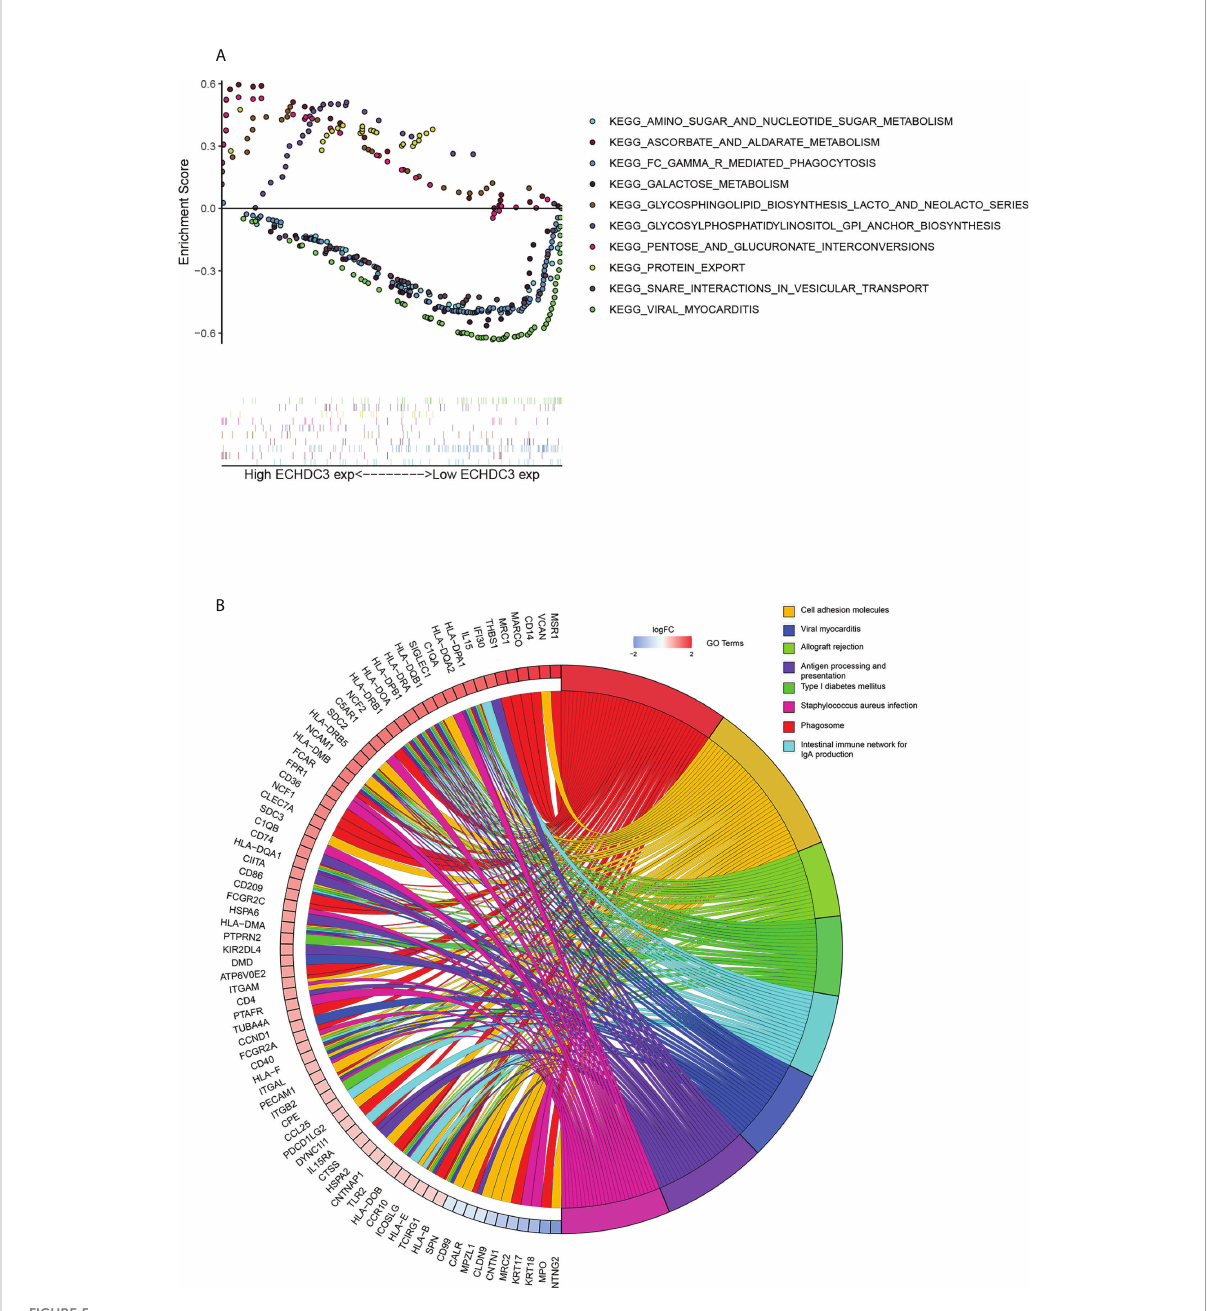
FIGURE 5 Bioinformatic analysis of ECHDC3 function. (A) Enriched KEGG pathways in ECHDC3 high and ECHDC3 low AML patients by GSEA. (B) GO Chord plot: ECHDC3 differentially expressed genes were linked via ribbons to the assigned terms, blue-to-red coding indicated